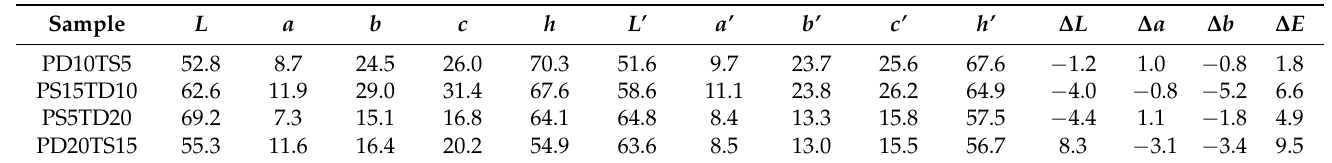
Table 2. The color difference values of coating (normal atmospheric temperature 26 ◦ C: L , a , b , c , and h and high temperature 40 ◦ C: L’ , a’ , b’ , c’ , and h’